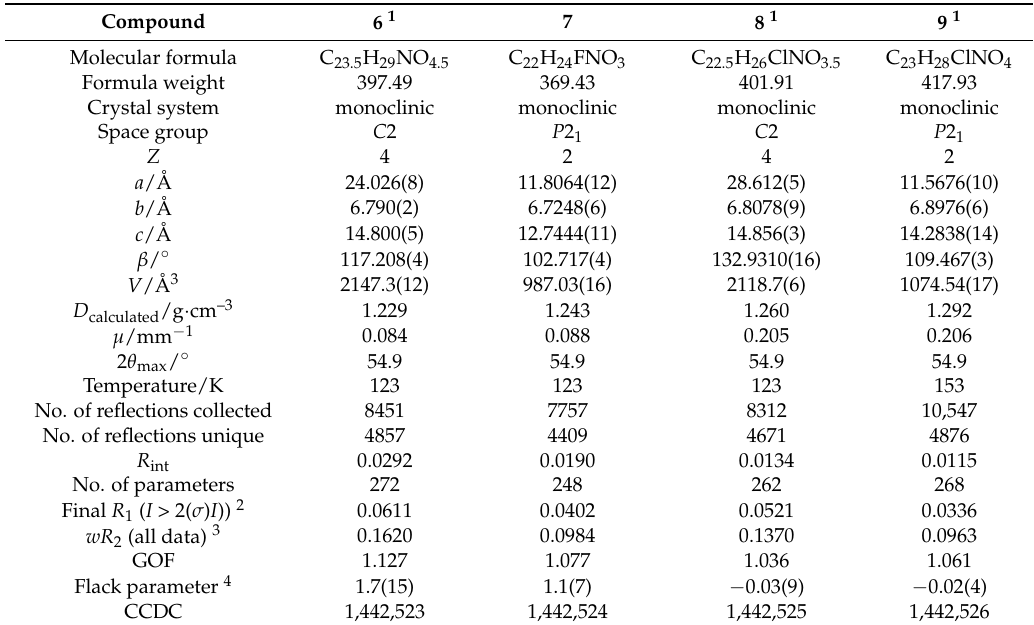
Table 1. X-ray crystallographic data for salts 6 – 9